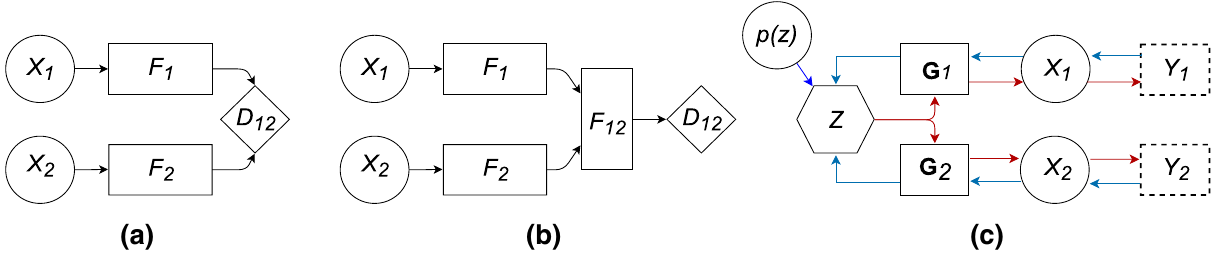
Figure 1. Multimodal Sensor Fusion: ( a ) Decision fusion, ( b ) Feature fusion, ( c ) Our technique: fusion in the latent representation Z with optional compressed sensing measurements; Red arrows show the generative model from the latent space and the data subsampling; Blue arrows show the fusion process, guided by the prior model. F features, p ( z ) prior model, G generators, X complete data, Y subsampled data. For clarity M = 2 modalities are shown, the concept generalises to any M